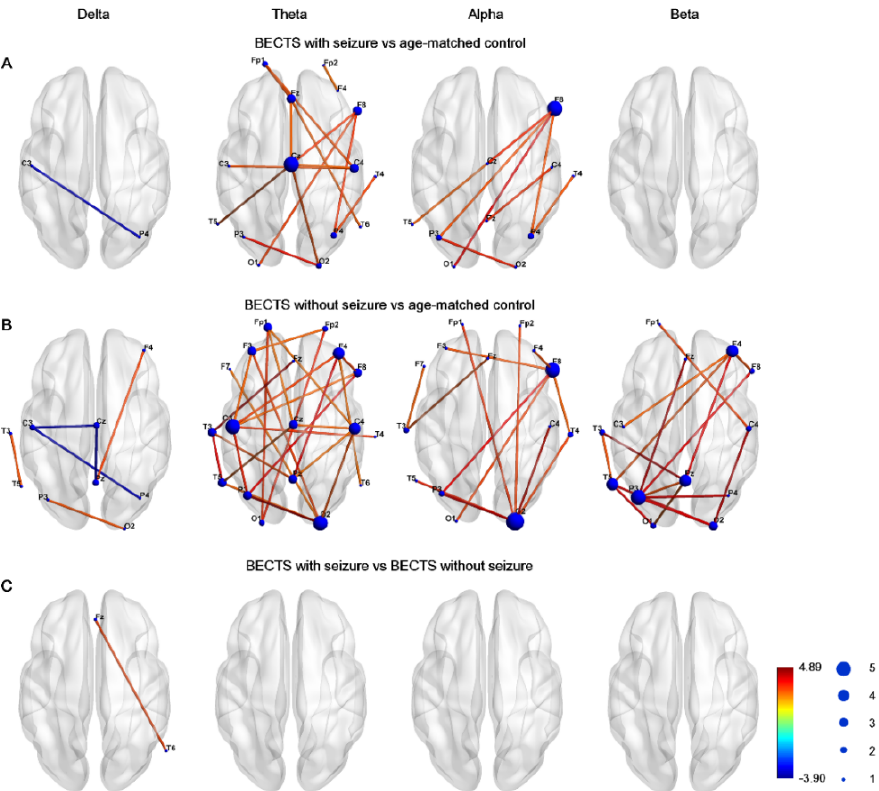
Figure 1. Graphs demonstrated network–based statistics of edges in different frequency bands in ( A ) BECTS with seizures, ( B ) BECTS without seizures, and ( C ) age–matched control groups. Line color represented t value between each pair of channels across all subjects in each group. The size of node represented frequency of significance in each node. Note there was higher strength between BECTS with or without seizures compared to age-matched controls in the theta band.